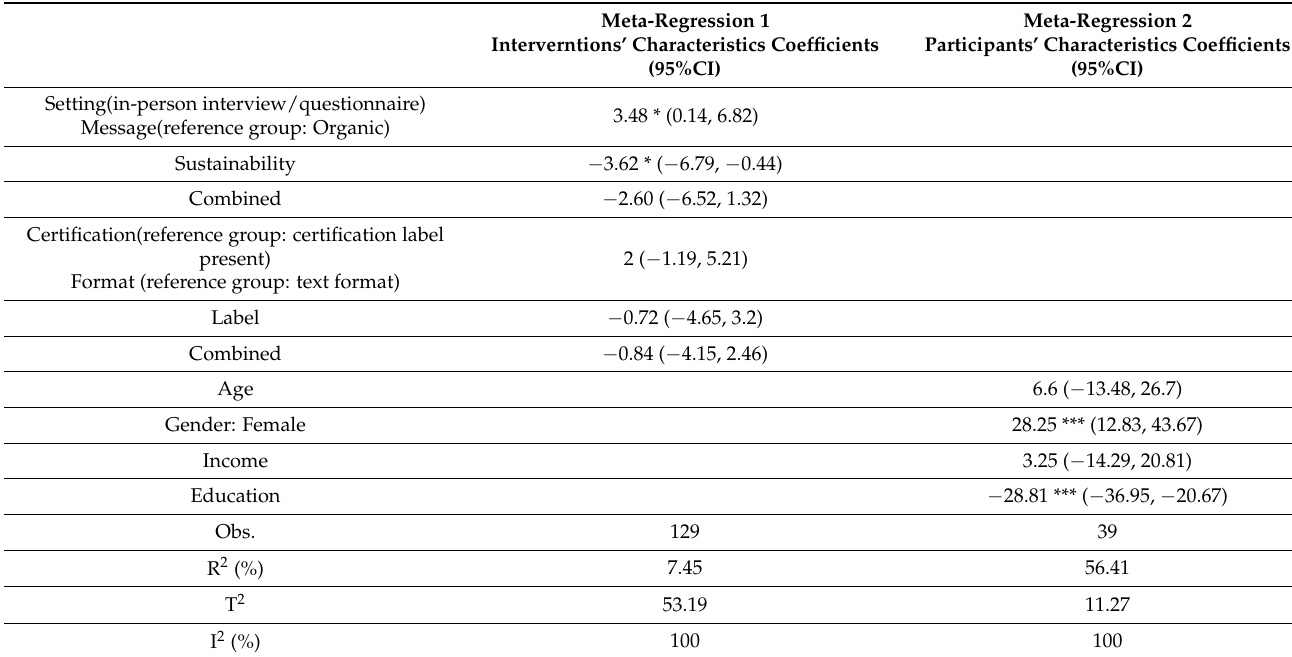
Table 1. Meta-regression results (measuring MWTP in